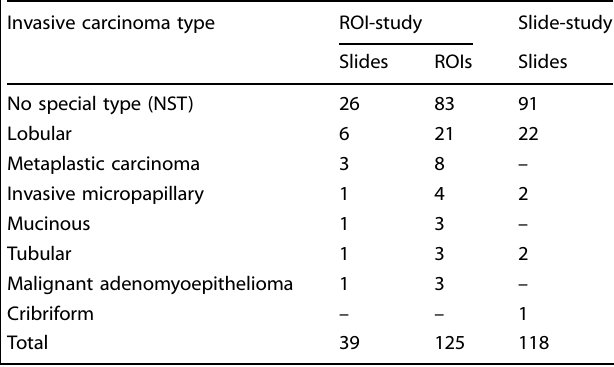
Fig. 8 Examples of sub-optimal behaviour of the proposed algorithm. Non-invasive malignant and benign tissue, outlined in burgundy and cyan colors, respectively, could be mistaken as invasive tumor by the epithelial cell detection network. This sub-optimal behavior altered the quantized pleomorphism scores of two slides by one in the test set. The slide on the left ( a ) had a highly pleomorphic tumor region, which suggested a quantized pleomorphism score of 3, but the low scores from the benign areas pulled down the overall score to 2. All four pathologists scored 3 for the slide. Similarly, the pleomorphism score of the slide on the right ( b ) should have been 2, evident by the tumor region in yellow color, but it was quantized to 1 due to the low scores from the large benign area. All four pathologists scored 2 for the slide. Table 3. Distribution of the tumor types in the ROI- and